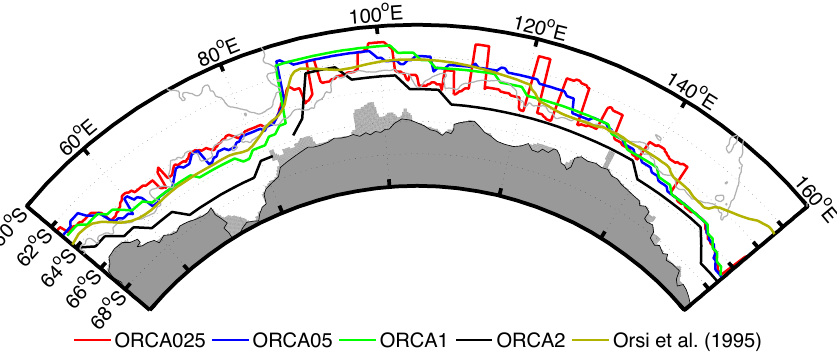
Fig. 5. Position of the maximum cumulative westward transport (Northern limit of the ASC) along the East Antarctic coast between 50 ◦ E to 160 ◦ E. The grey line corresponds to the bathymetry line 3500m. The color code used is the same as in Fig. 3. The brown line represents the southern boundary of the ACC (northern boundary of the ASC) provided by Orsi et al., (1995). Presence of peaks in ORCA025 is due to the existence of stationary eddies in the model.